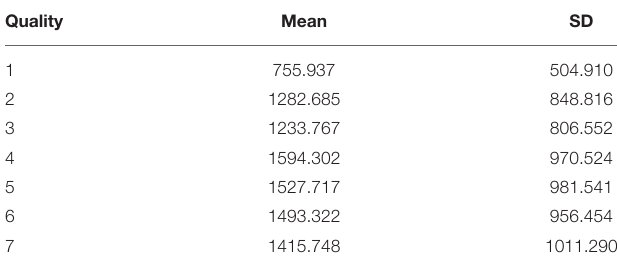
TABLE 5 | Descriptive statistics for the evaluation levels of the Quality dimension. Quality